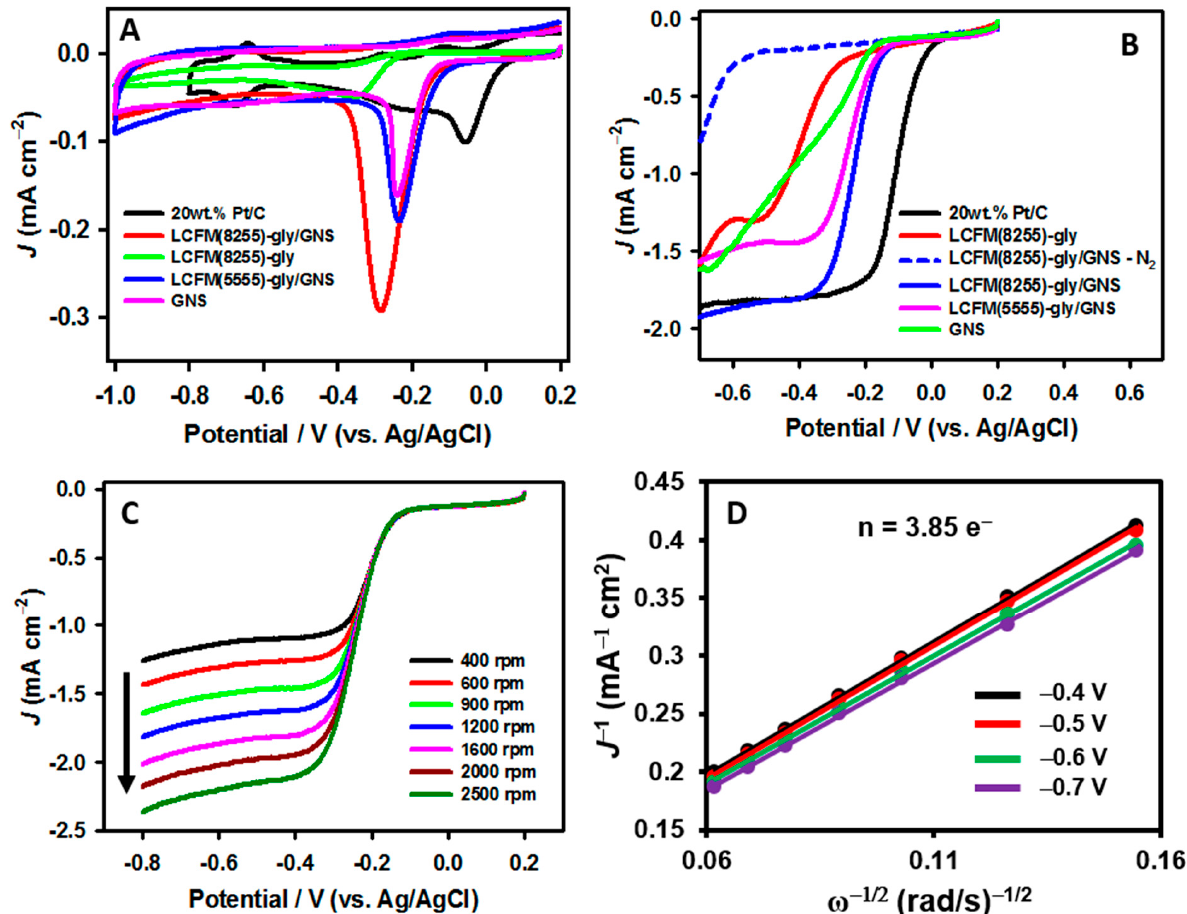
Figure 5. ( A ). CVs and ( B ). LSVs for ORR kinetics at various electrodes recorded in O 2 -saturated 0.1 M KOH; Scan rate: 20 mV s − 1 ; Rotation speed: 1600 rpm for LSV measurements. ( C ). LSVs of RDE measurements using LCFM(8255)-gly/GNS composite electrode at various rotation speeds from 400 to 2500 rpm in O 2 -saturated 0.1 M KOH; Scan rate: 20 mV s − 1 , ( D ). Koutecky–Levich plot of j − 1 vs. ω − 1/2 .